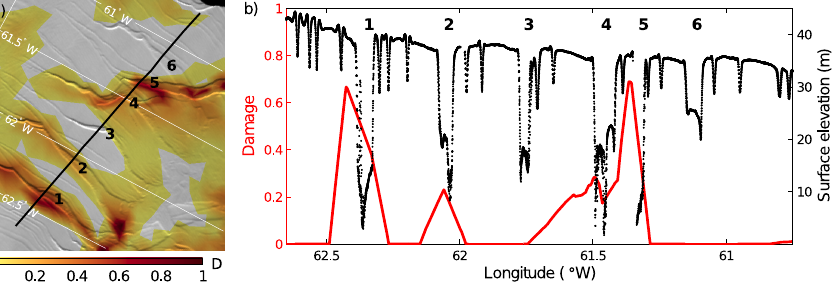
Fig. 7. (a) Damage for the inset shown in Fig. 4a plotted over a 2009 MOA image. Black line is a segment of an Operation IceBridge flight line from 2009. Rifts that cross the track are numbered 1–6 for comparison with panel (b) , which shows damage (red, left) and IceBridge ATM surface elevation above mean sea level (black, right) using the GL04c geoid (Fretwell et al.,